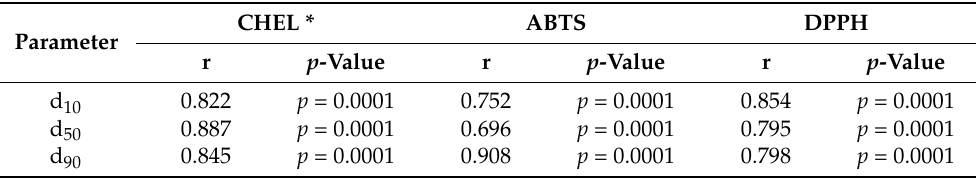
Table 6. Correlation coefficients and p -values describing the relation between the parameters of PSD and antioxidant activity of OH.